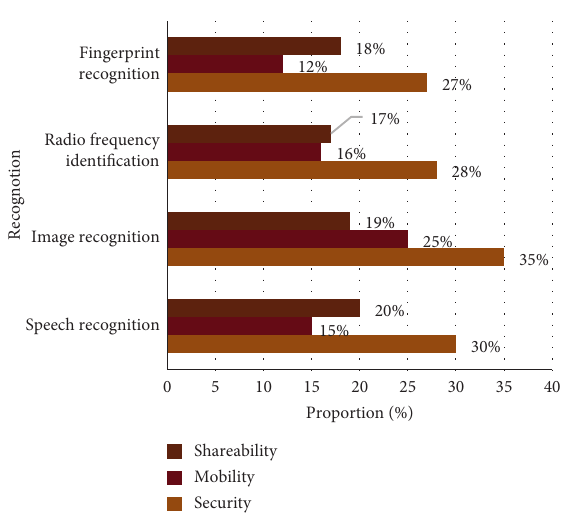
Figure 5: Key issues of information recognition